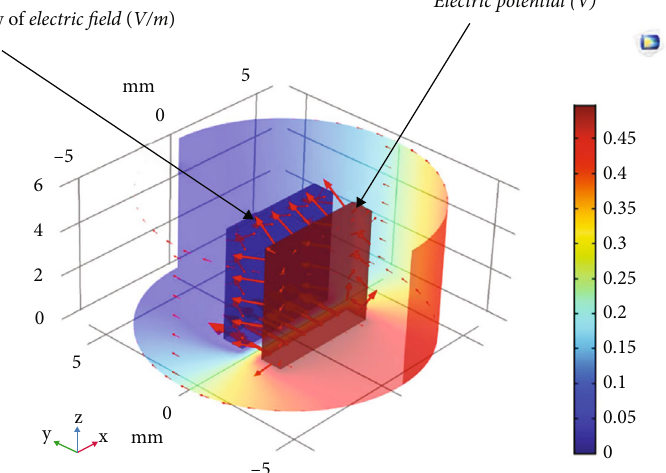
Figure 9: Variation of the potential and electric fi eld along the distance inside the olive oil A sample (as an example).